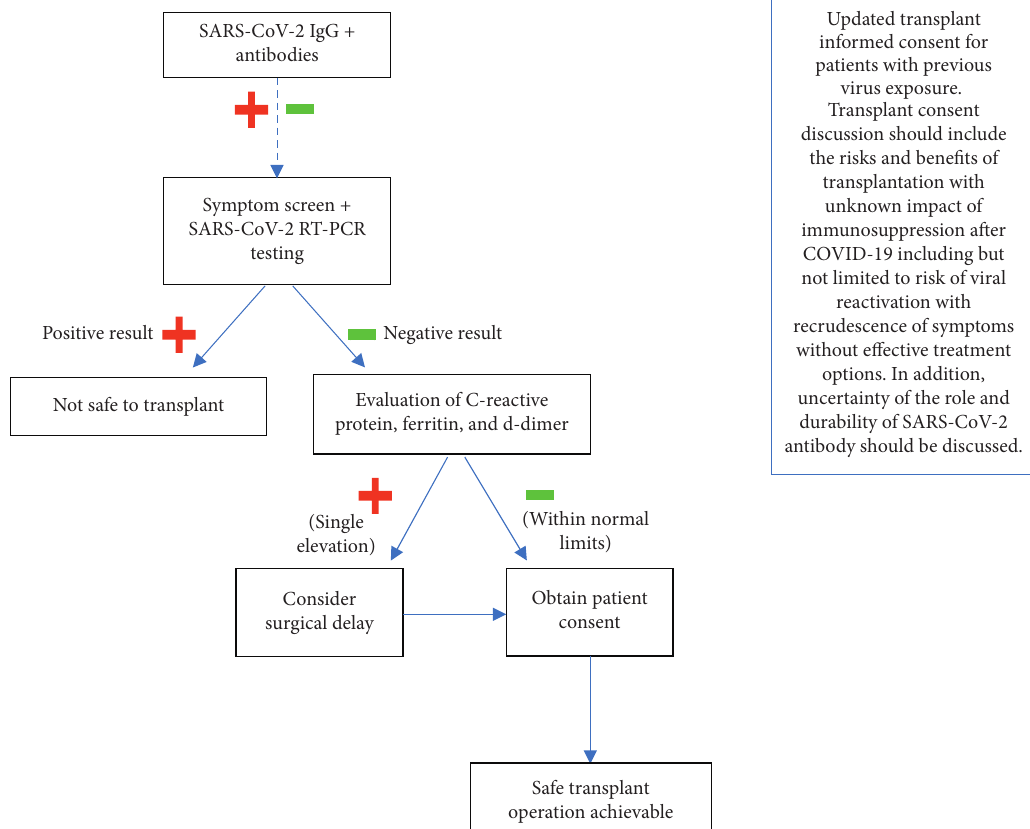
Figure 1: Protocol for transplant pre-operative evaluation for all transplant candidates during COVID-19